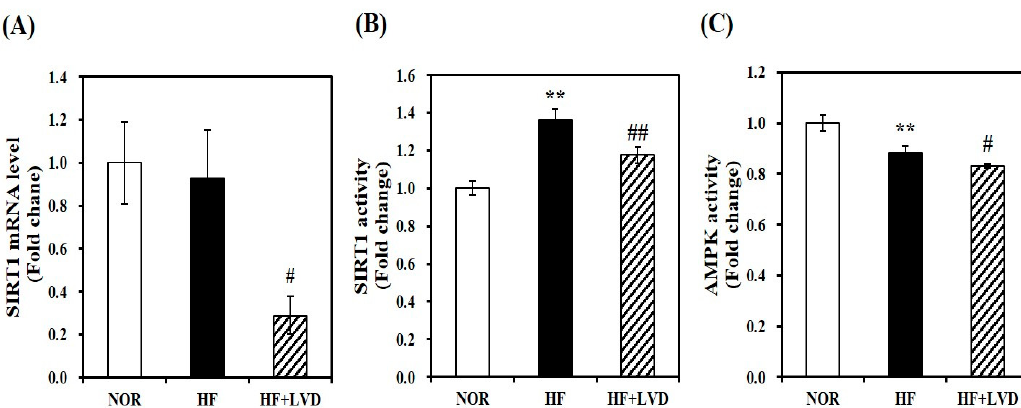
Figure 5. The effect of vitamin D inadequacy on sirtuin 1 (SIRT1) gene expression and adenosine monophosphate-activated protein kinase (AMPK) / SIRT1 activation in muscle tissues. SIRT1 mRNA expression was determined by qRT-PCR, normalized for all samples to β -actin, and expressed as the fold change compared to NOR group ( A ). Measurement of SIRT1 activity ( B ) and AMPK activity ( C ) was carried out using commercial assay kits, normalized to protein concentration, and expressed as the fold change to the NOR group. Results are expressed as mean ± SEM ( n = 7–9 per group). ** p < 0.01 compared to NOR. # p < 0.05; ## p < 0.01 compared to HF. NOR, 10% fat diet with 1000 IU vitamin D; HF, 45% fat diet with 1000 IU vitamin D; HF + LVD, 45% fat diet containing 25 IU vitamin D.